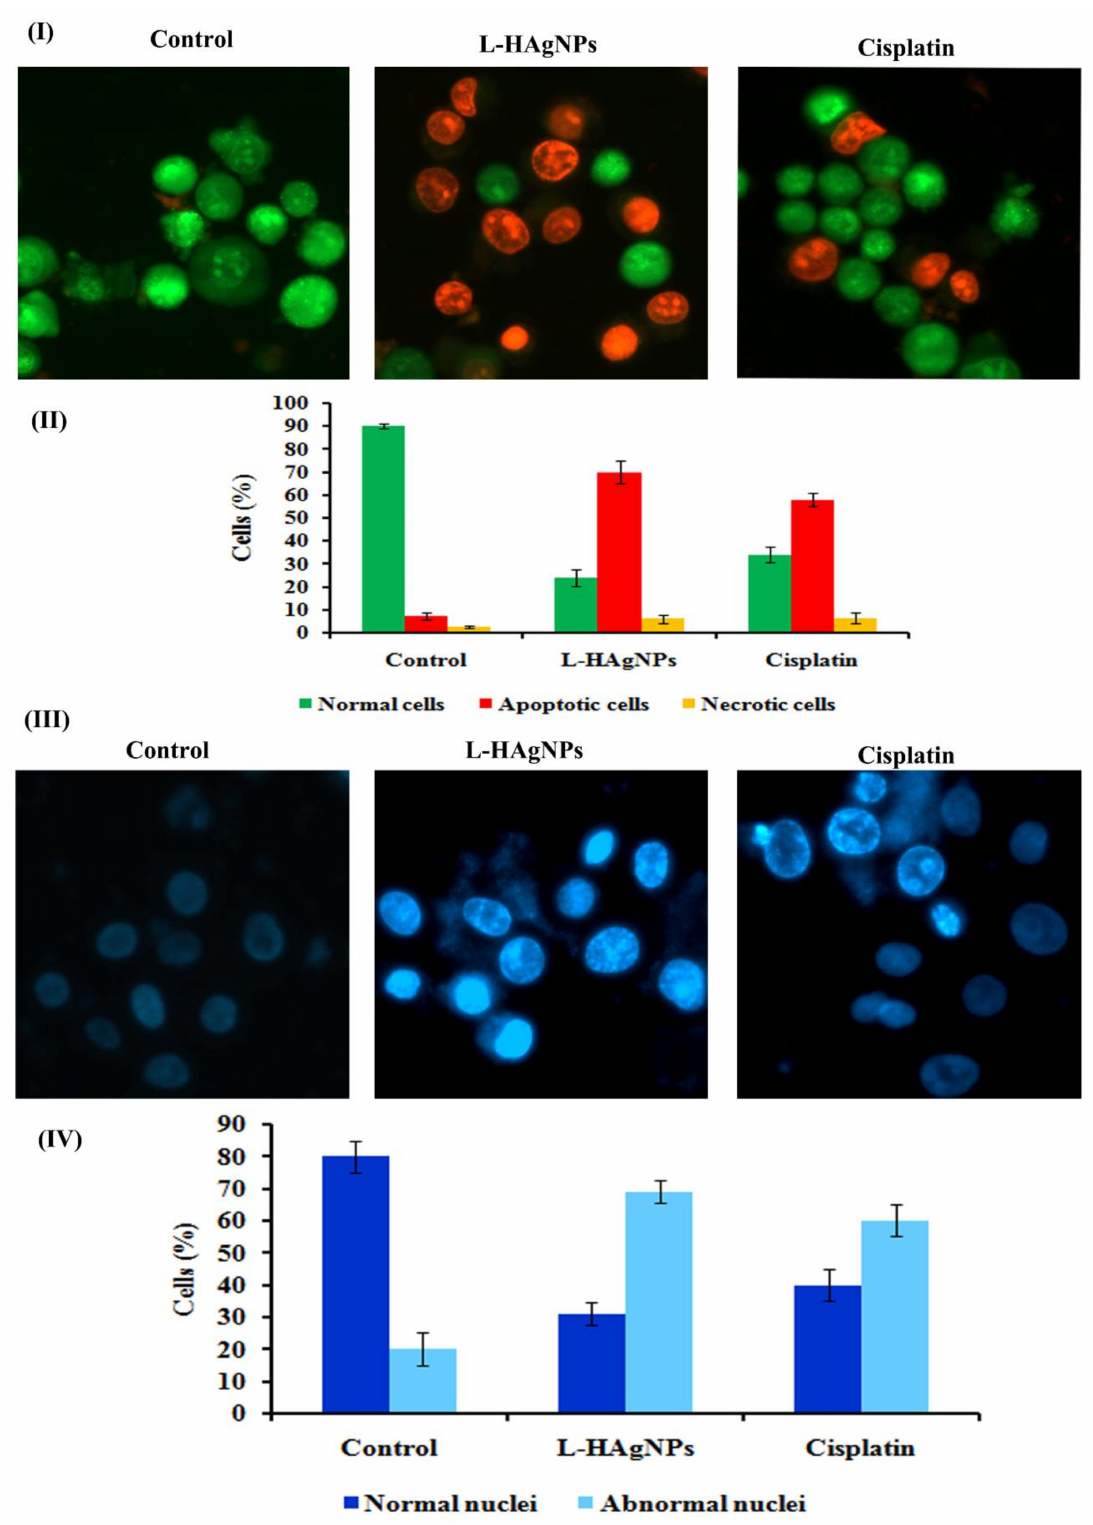
Figure 7. Assessment of apoptotic effect of L-HAgNPs against cervical cancer cells: ( I ) fluorescent image of AO/EtBr dual staining; ( II ) quantification of apoptotic and necrotic cells; ( III ) images representing nuclear damage by Hoechst 33,528 staining; ( IV ) bar graph illustration percentage of cells with normal and apoptotic